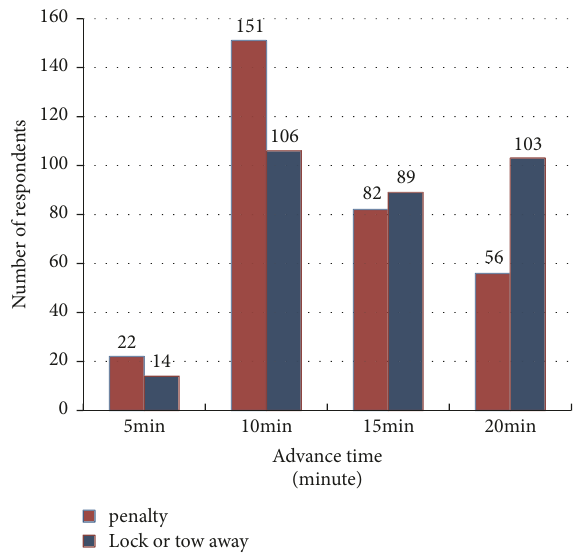
Figure 8: The effect of punishment on the department